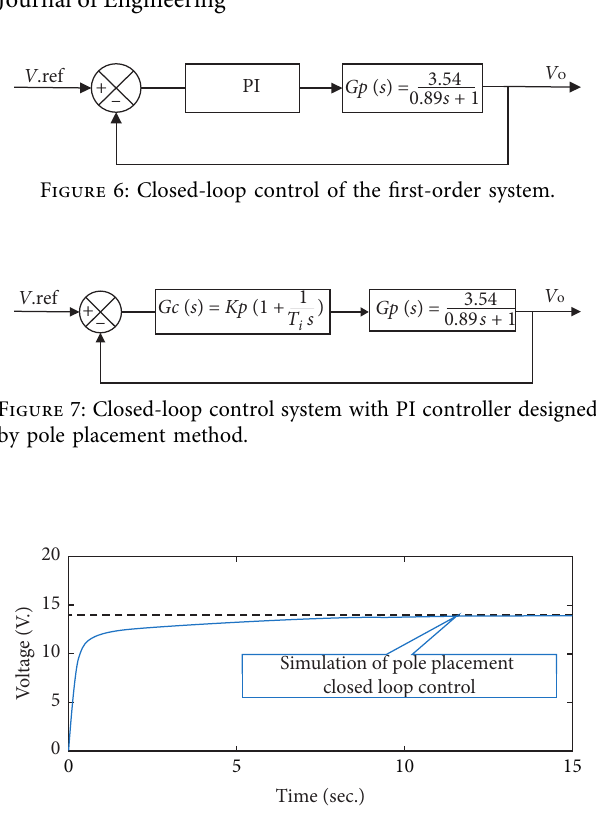
Figure 8: Simulation of closed-loop control using PI controller designed by pole placement method.